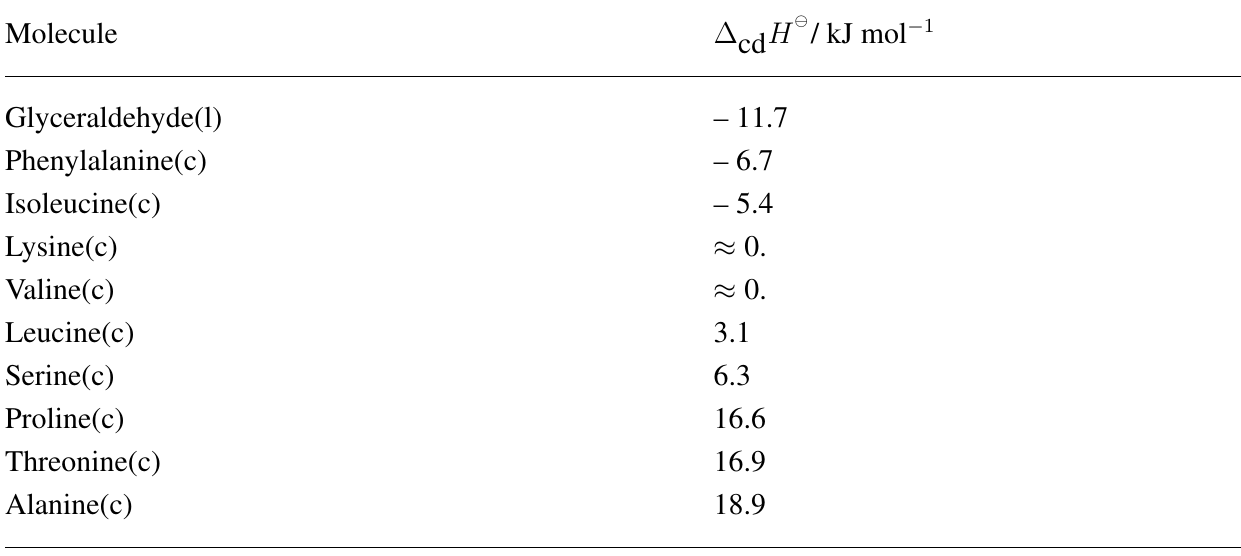
Table 1 . Strength of chiral discrimination for different